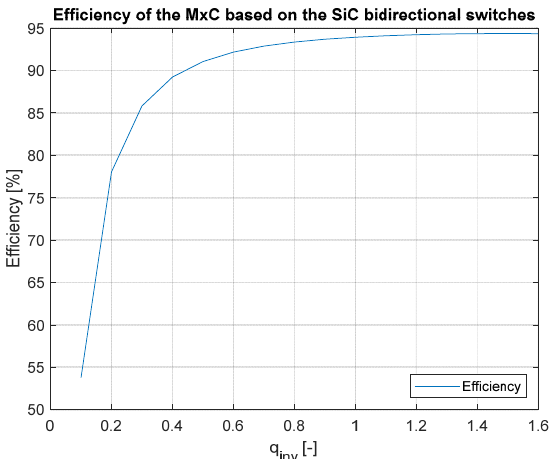
Figure 10. Simulated efficiency of the SiC-based MxC.